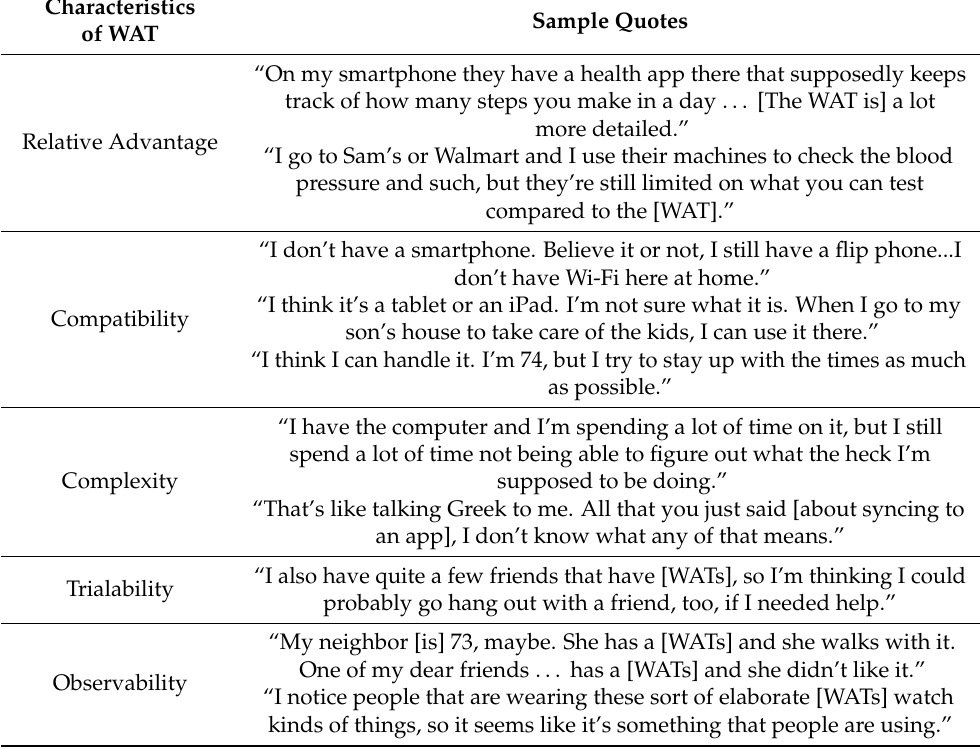
Table 3. WAT Characteristics and Participant